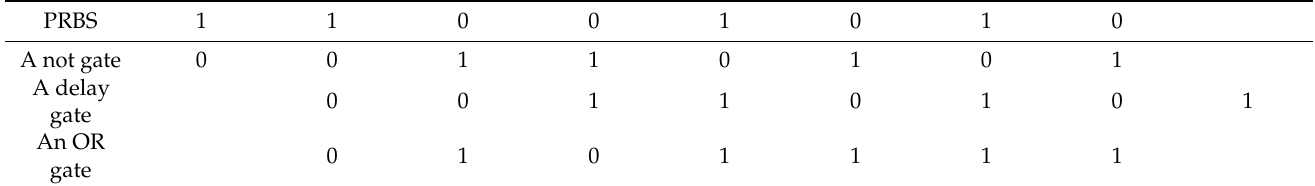
Table 3. Modulation pattern conversion process of DPSK signal.